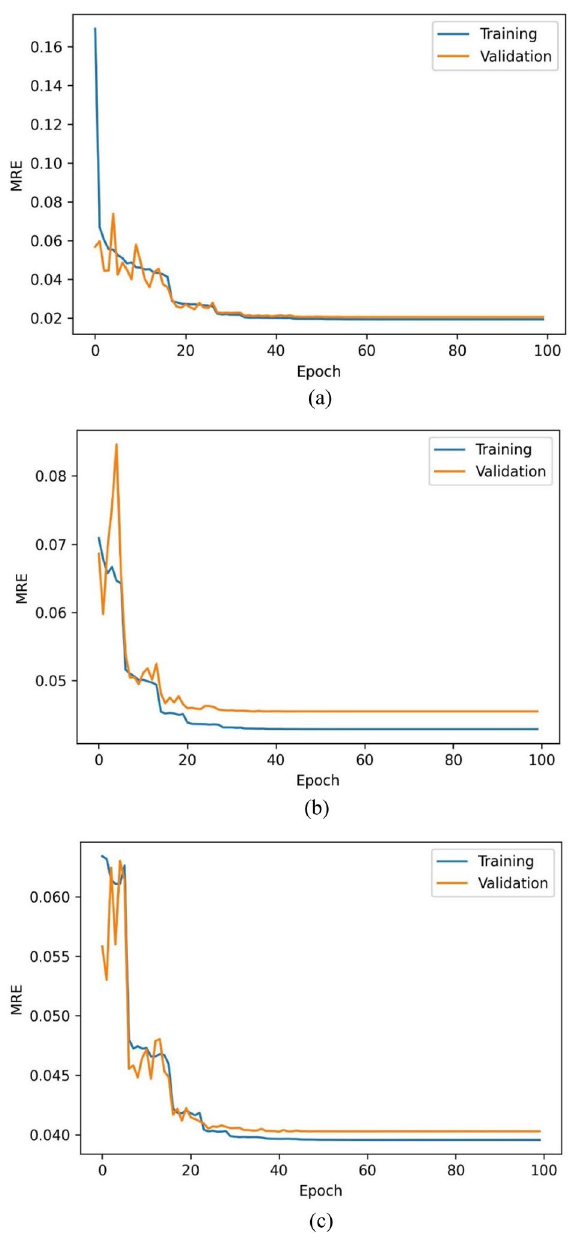
Figure 6. MRE of ANN regressor models for ( a ) HO-IA, ( b ) HO-NF, and ( c )